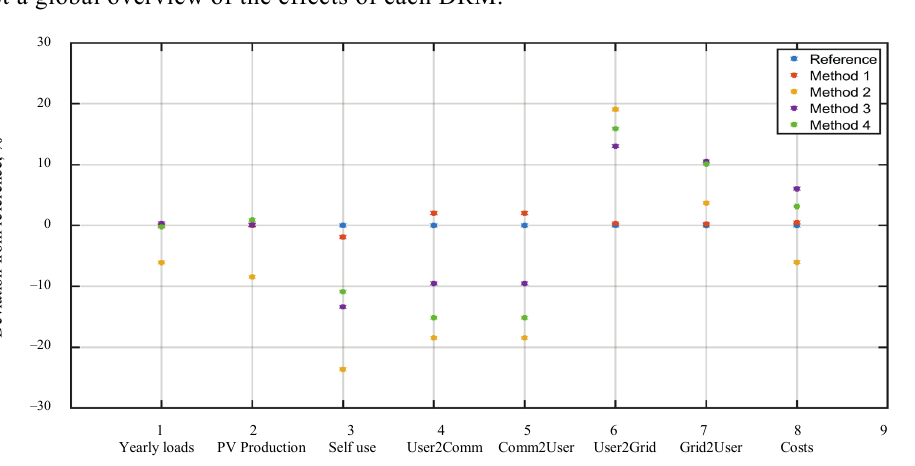
Fig. 3. Summary of the results of scenario